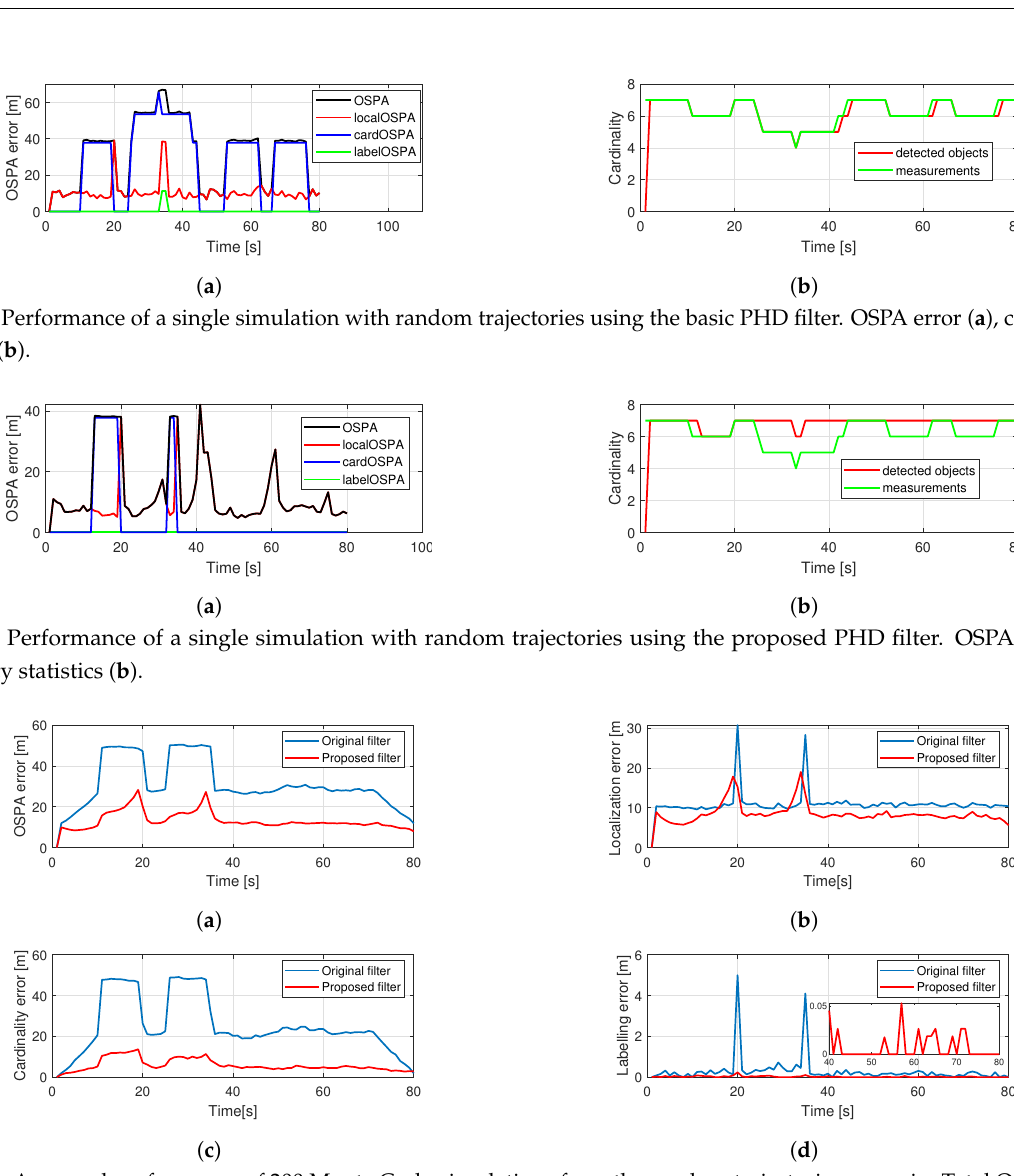
Figure 10. Averaged performance of 200 Monte Carlo simulations from the random trajectories scenario. Total OSPA error ( a ), localization error ( b ), cardinality error ( c ), labeling error ( d